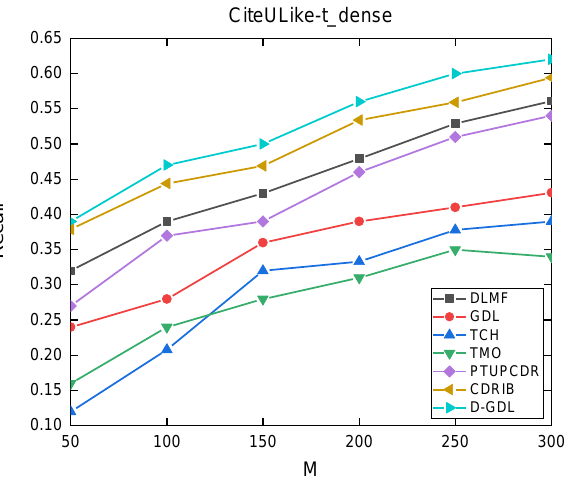
Figure A5. Performance of D-GDL against the comparative approaches based on recall vs. M for CiteULike-a dataset in the dense setting.